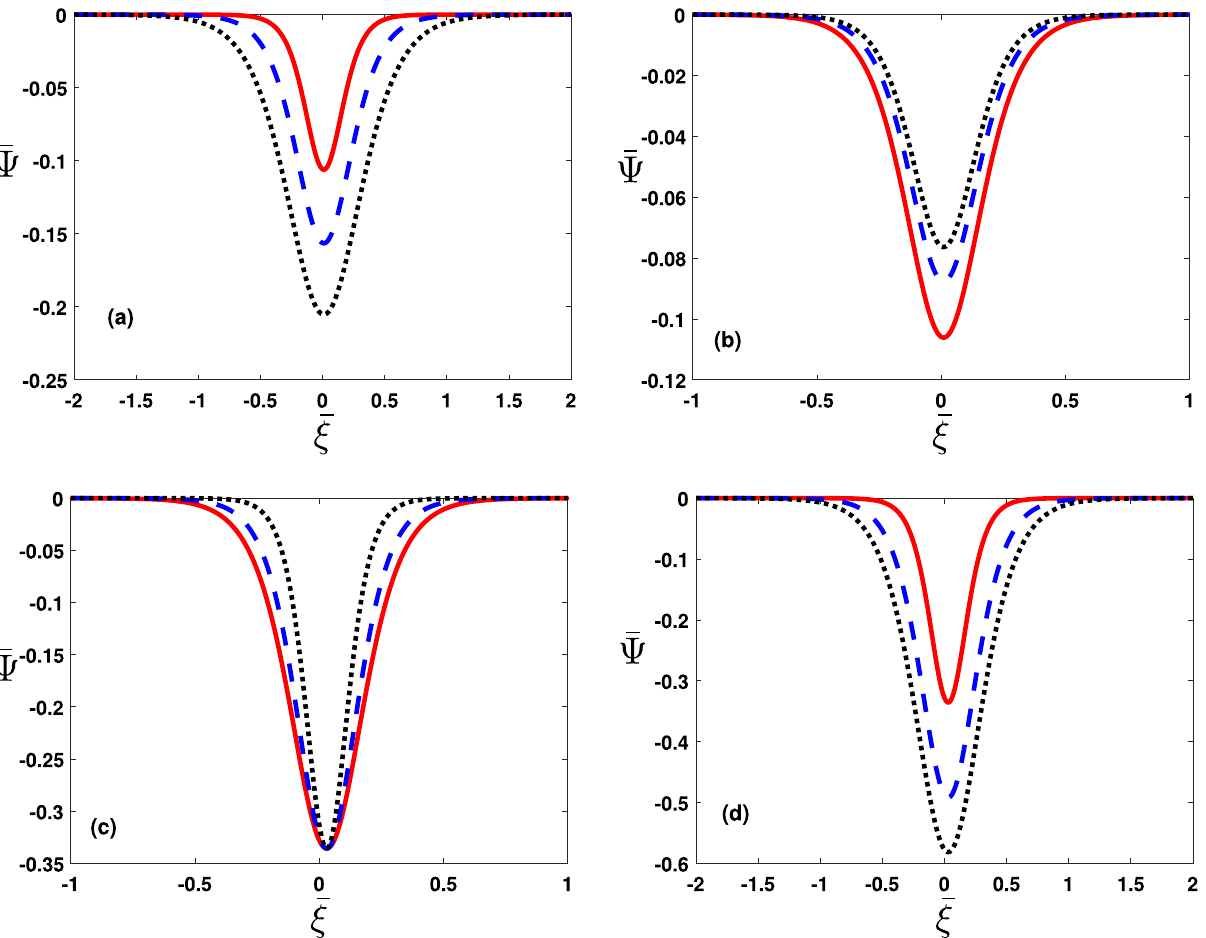
10 − 11 statV given in Eq. (44) is taken against φ/φ 0 with φ 0 Figure 5. The approximate solution ( ¯ � = = ξ K 0 ) by changing ( a ) hot electrons temperature values as T h the spatial variable ¯ ξ( = 1.1 10 3 K (dashed curve) and 1.2 10 3 K (dotted curve), ( b ) cold electrons temperature values as T c × × 10 3 K (dashed curve) and 2.5 10 3 K (dotted curve), ( c ) U ( 0 ) values as 2 (solid curve), 1.5 × × 10 12 cm s − 1 (dashed curve) and 20 10 12 cm s − 1 (dotted curve) and ( d ) changing κ e values as 2 curve), 10 × × (solid curve), 3 (dashed curve) and 5 (dotted